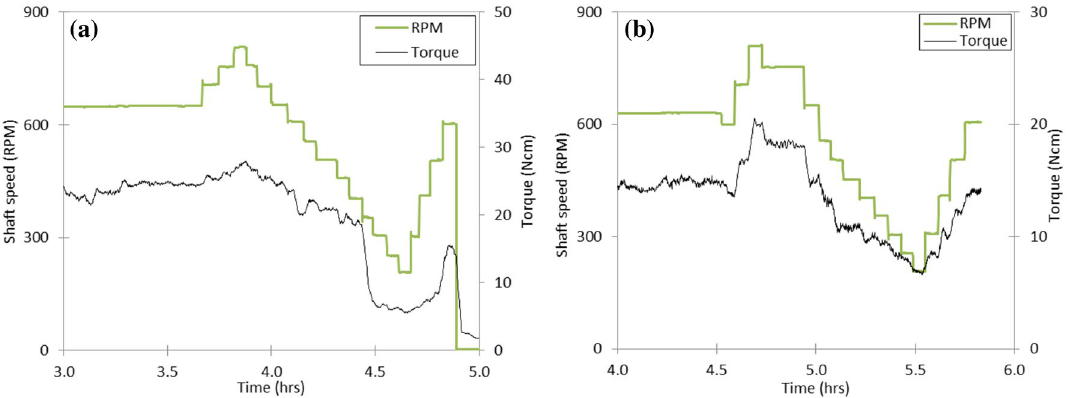
Fig. 5 Torque response during shaft speed ramps, a run 2, and b run 5